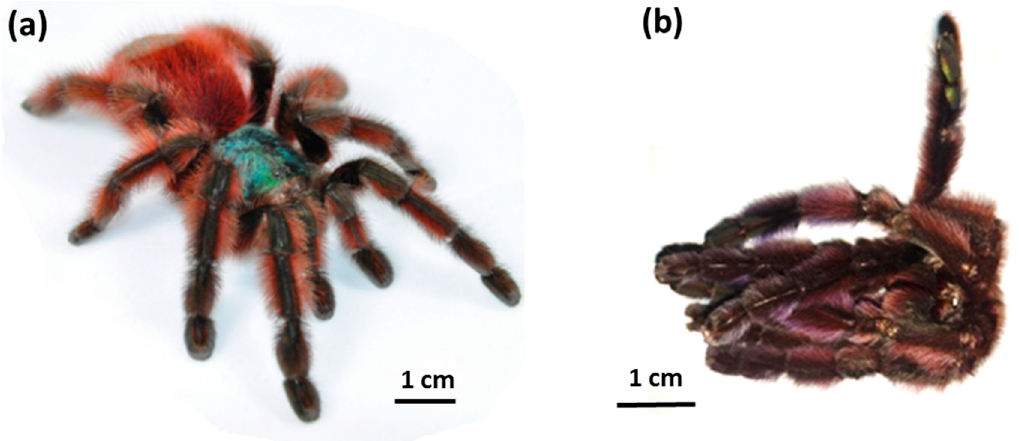
Figure 1. ( a ) Live adult female of the spider Caribena versicolor (Theraphosidae) (photo by Krzysztof Siorak), and ( b ) the molt of the same organism as used during this study.